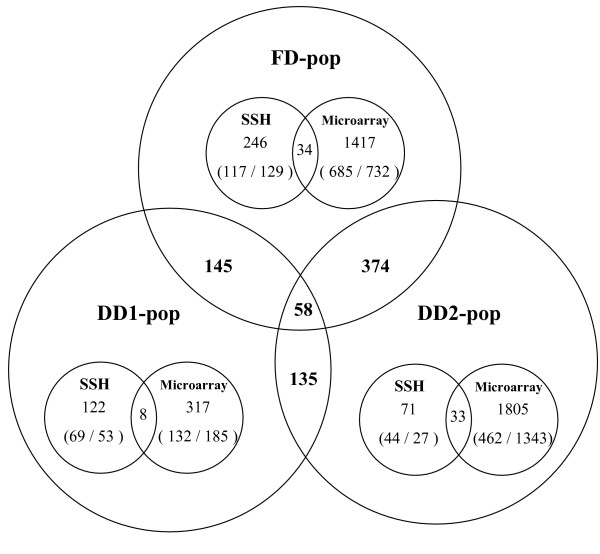
Venn diagram for the summary of differentially expressed ESTs identified from FD (Flint × Dent, AS08 × AS 06), DD1 (Dent × Dent, AS11 × AS09), and DD2 (Dent × Dent, AS29 × AS30) mapping populations, respectively. Total numbers of genes differentially expressed are indicated in respective circles. In parentheses, the first number indicates up-, the last number down-regulated genes. The number of genes simultaneously up- or down-regulated is given in intersections between circles.